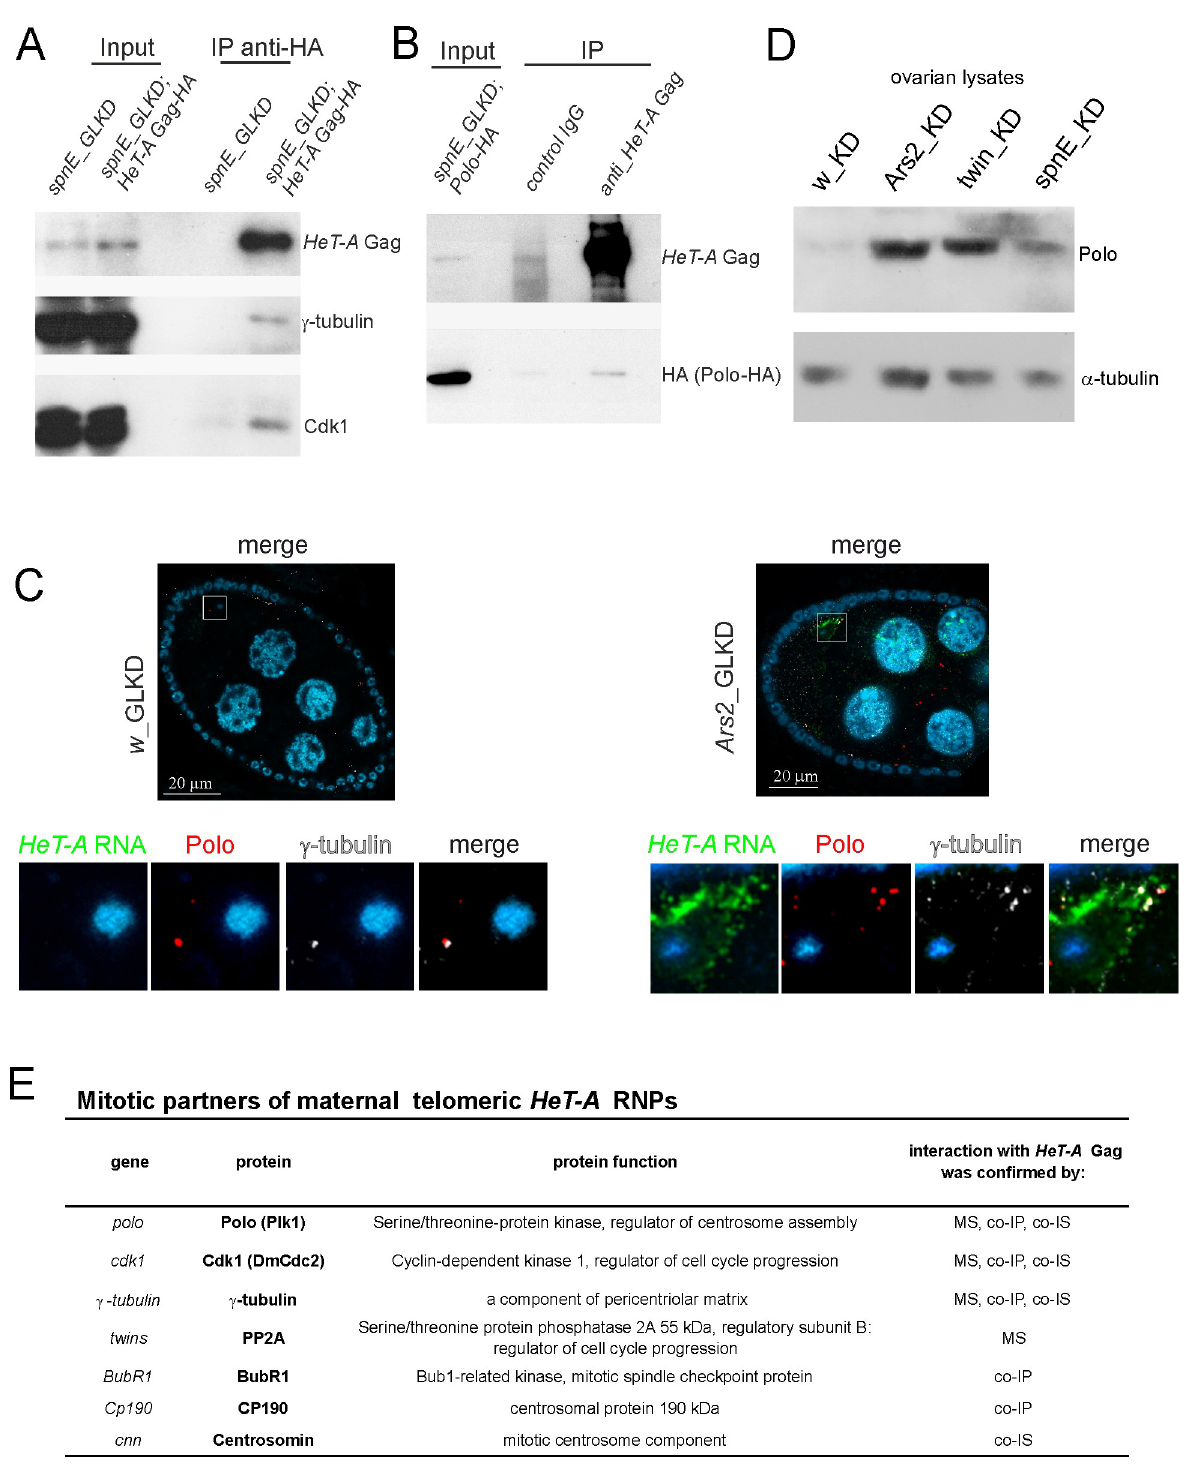
Fig 3. HeT-A ribonucleoprotein particles interact with Polo during oogenesis. (A) A coimmunoprecipitation experiment was performed on ovarian extracts from spnE _GLKD flies expressing HeT-A Gag-HA. (B) A co-IP experiment was performed on ovarian extracts from spnE _GLKD flies expressing Polo-HA. The samples were separated by SDS-PAGE and analyzed by western blotting using the antibodies indicated on the right. The starting lysate (input) and immunoprecipitated (IP) probes are indicated; the antibodies used for co-IP are indicated above the IP lanes. (C) HeT-A RNA FISH (green) combined with immunostaining of Polo (phosphorylated form, red) and γ -tubulin (grey) in the control (left panel) and Ars2 _GLKD ovaries (right panel). Egg chambers at 9–10 stages of oogenesis are shown. The lower panels show the enlarged areas highlighted by